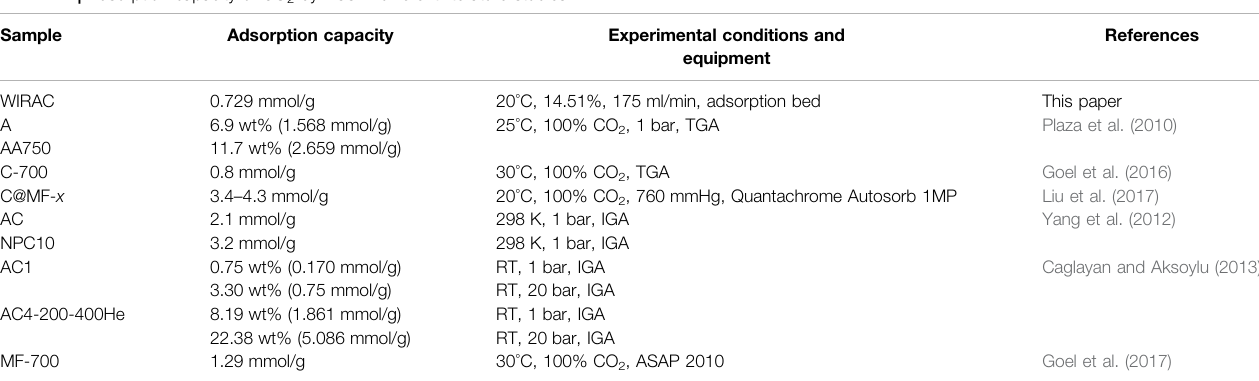
TABLE 2 | Adsorption capacity of CO 2 by ACs in different literature studies.